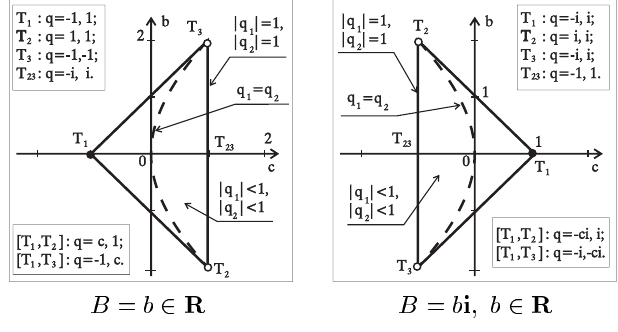
Figure(cid:4)(cid:1)RootsinthecaseB(cid:17)bandB(cid:17)bi(cid:0)b(cid:2)R(cid:0)c(cid:2)R(cid:1)